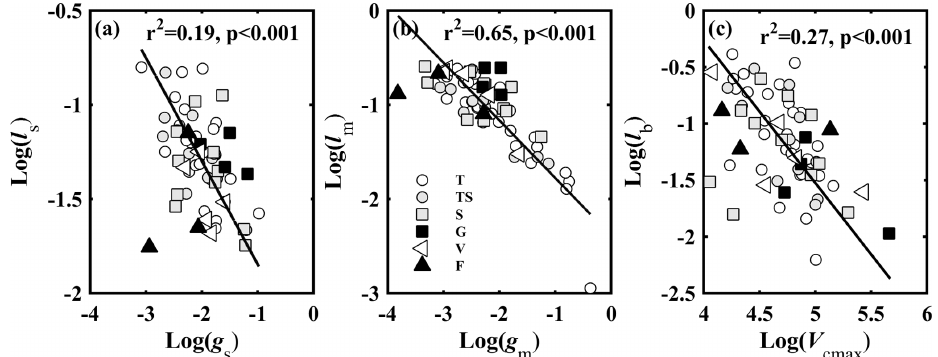
Figure 4. Relationships between (a) stomatal conductance to CO 2 ( g s , molCO 2 m − 2 s − 1 ) and l s ( g s limitation on light-saturated net photo- synthesis; A ); (b) mesophyll conductance to CO 2 ( g m , molCO 2 m − 2 s − 1 ) and l m ( g m limitation on A ); and (c) the maximum carboxylase activity of Rubisco ( V cmax , µmolCO 2 m − 2 s − 1 ) and l b ( V cmax limitation on A ). Lines refer to regression line for 63 species. T, TS, S, G, V, and F represent tree, tree/shrub, shrub, grass, vine, and fern,